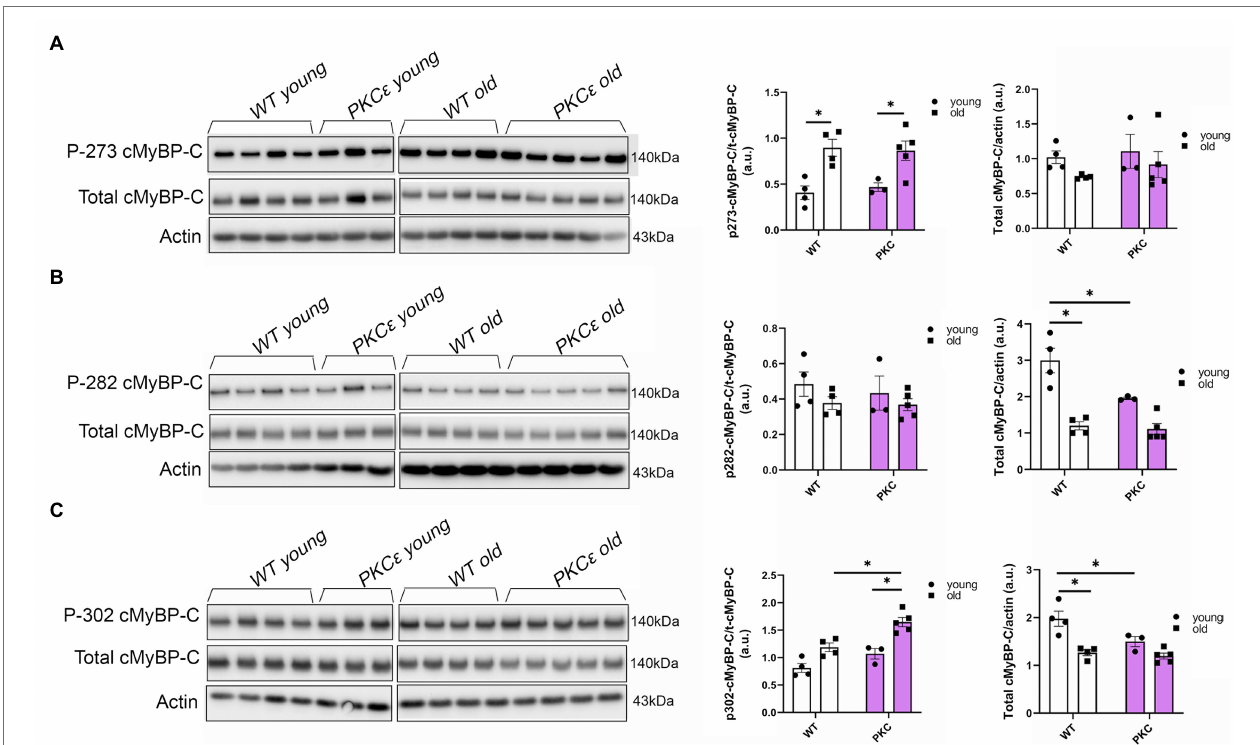
overexpression mouse model. Western blot images show phosphorylation of cMyBP-C FIGURE 5 | Phosphorylation of cMyBP-C at Ser302 is increased in a PKC ɛ at (A) Ser273, (B) Ser282, and (C) Ser302 with summarized quantification and actin as loading control. t-cMyBP-C: total cMyBP-C. Young: 3–6 months and old: 12–16 months. Data presented as mean ± SEM. N = 3–5. Outliers were identified with the ROUT method and excluded from analyses. Data analyzed with a two-way ANOVA post-hoc Fisher’s LSD test. * p <